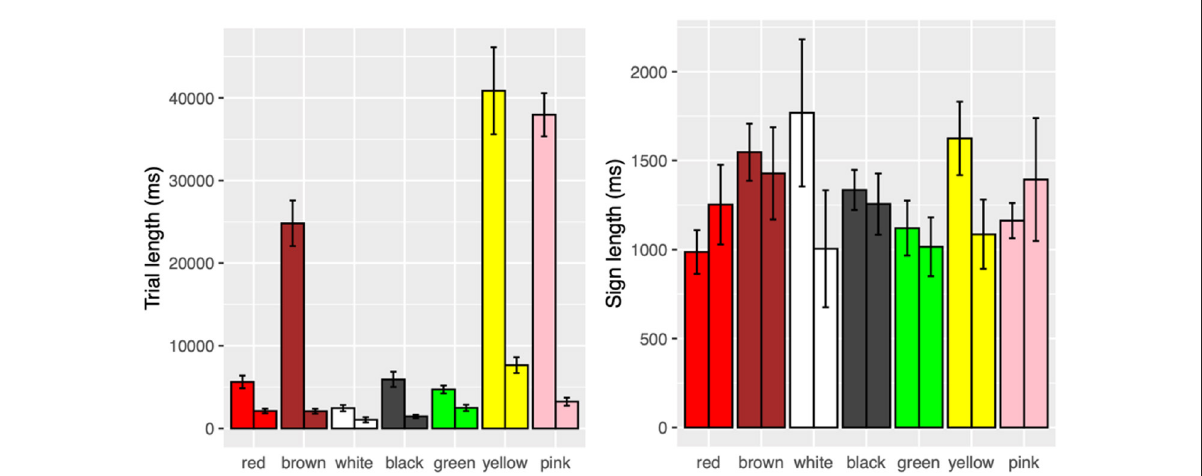
FIGURE5 Trial length and sign length for different target colors. (Left) Average length of trials (start of first turn to the participants noting a color difference on their sheet) for the first week (left bars) and the final week (right bars). (Right) Average length of individual sign variants for the first week (left bars) and the final week (right bars). Error bars (black lines) indicate the standard